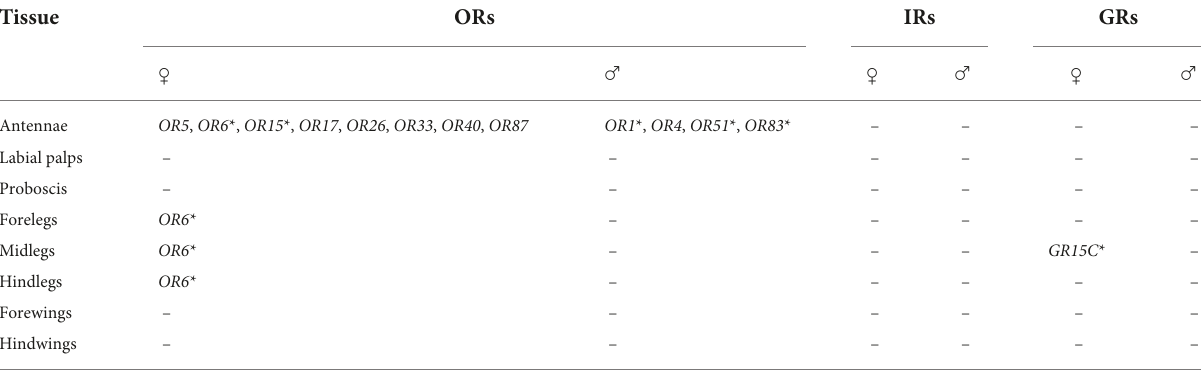
TABLE 2 Chemosensory receptor gene transcripts with a sex-biased